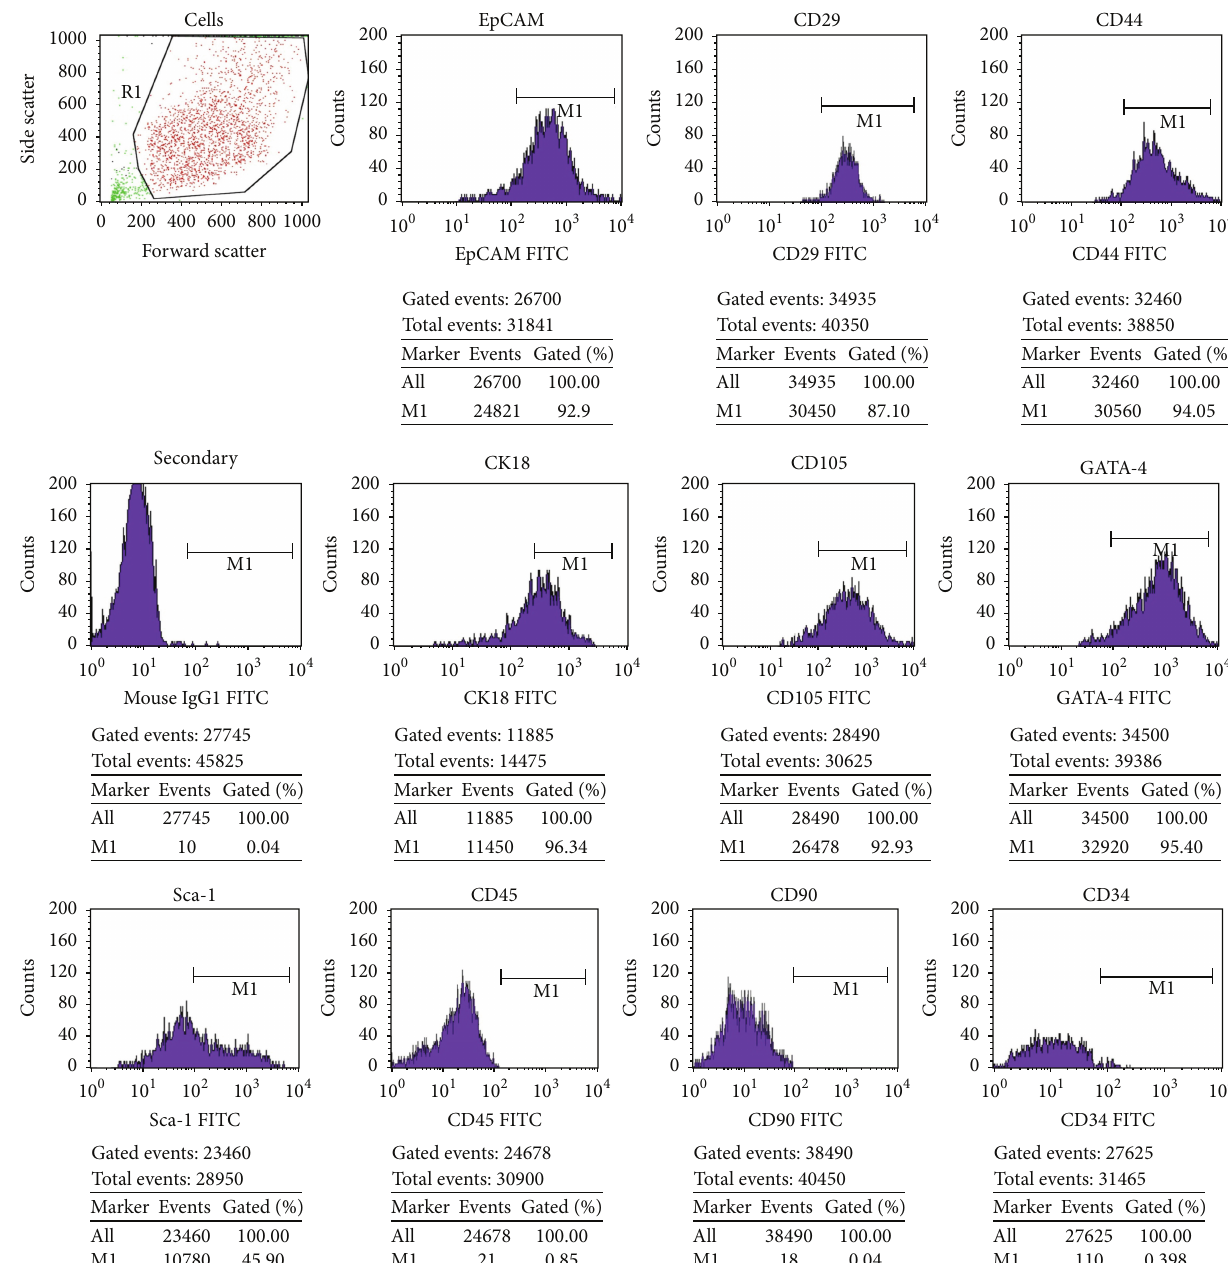
Figure 3: Immunophenotyping of LDSCs. Passaged 2 LDSCs were stained with fluorescein isothiocyanate (FITC) conjugated anti-mouse EpCAM, CD44, GATA-4, CD105, CD90, CD34, CK18 (Cytokeratin 18 (CK)), CD29, Sca-1, and CD45 along with its corresponding isotype control IgG1. FACS results showed that these cells were strong positive for liver stem cell markers EpCAM, GATA-4, CD44, CD105, CK18, and CD29 ( 𝛽 1 integrin) in addition to weak positive for Sca-1 and negative for hematopoietic markers CD45, CD34, and CD 90.